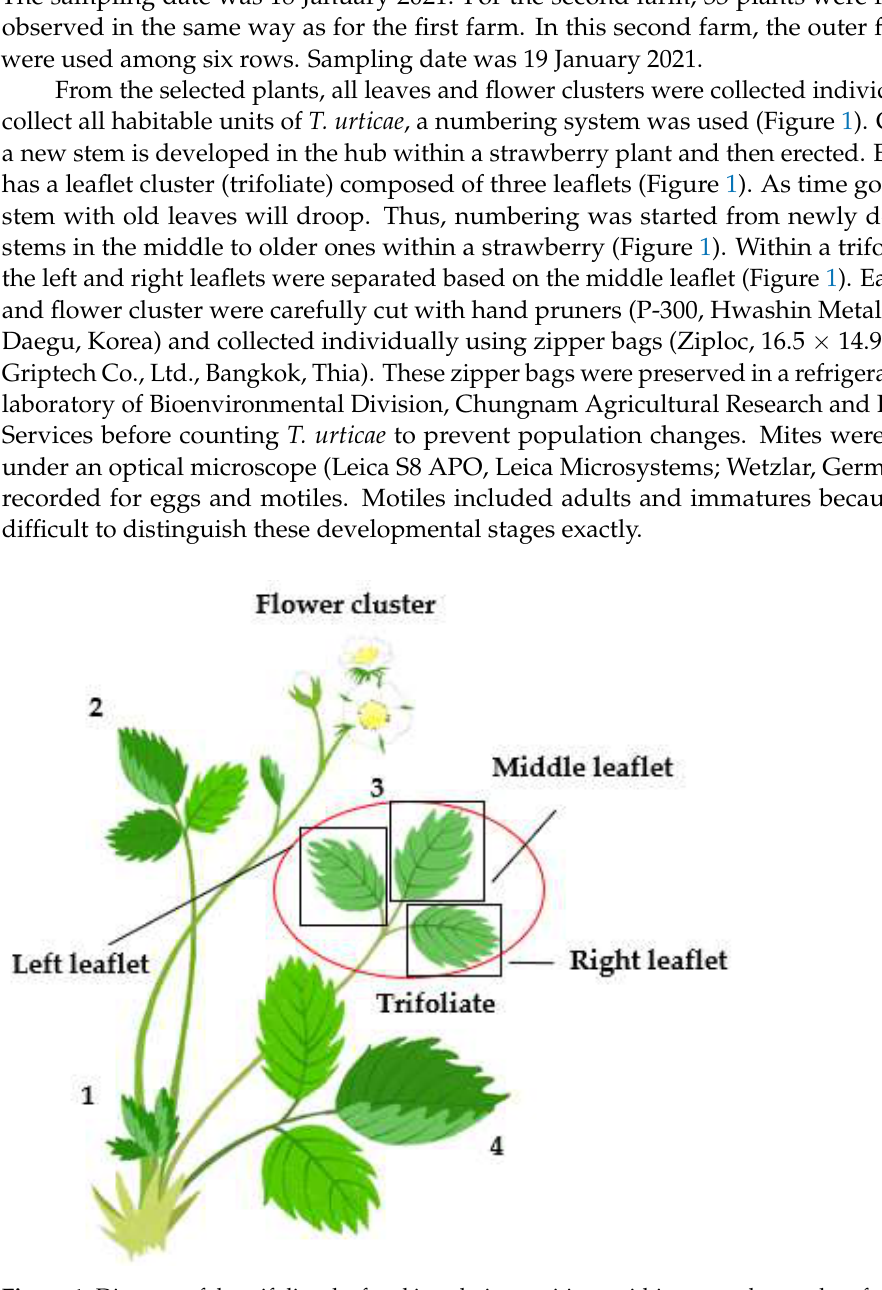
Figure 1. Diagram of the trifoliate leaf and its relative positions within a strawberry plant for sampling T. urticae in this study. Within a trifoliate leaf, the left and right leaflets were separated based on the middle leaflet. The numbers above trifoliate leaves indicate the numbering for sampling T. urticae . Numbering was started from newly developed leaves to older ones according to the leaf age. The flower cluster was separately recorded.